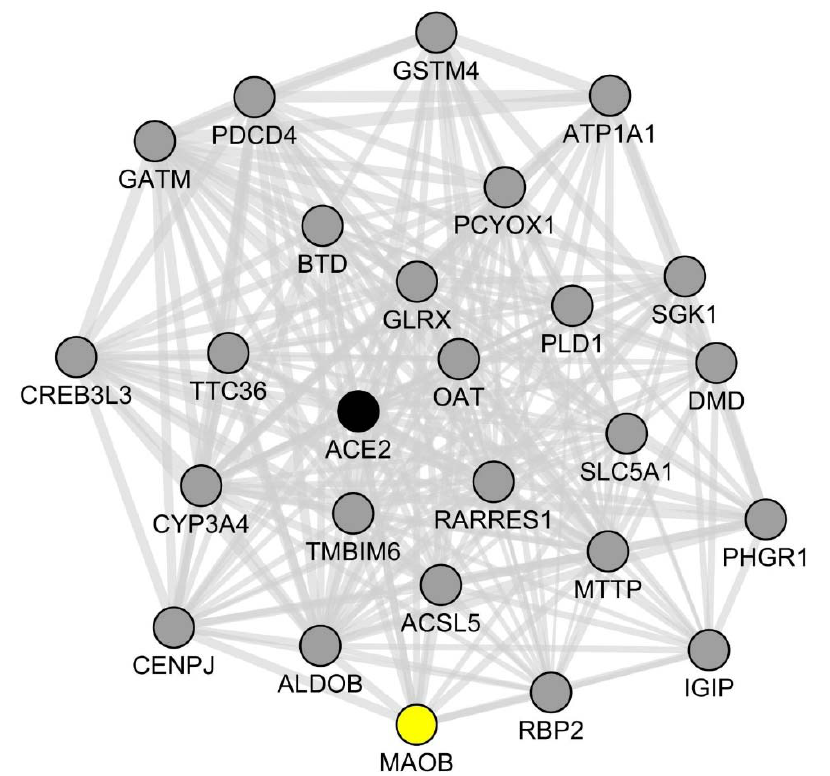
Figure 3. ACE2 co-expression network in SARS-CoV2-infected human intestinal organoids. A set of previously published RNA-seq data [34] obtained from the analysis of SARS-CoV2-infected human intestinal organoids was re-assessed in order to identify the top-25 genes that more closely co-express with ACE2 under these experimental conditions. Each gene is represented by its gene symbol and a plain circle. Each correlation link is represented by a plain gray line. The full list of ACE2 co- expressed genes is shown in Table S1. MAOB (represented as a yellow plain circle), a crucial gene of the dopamine/trace amines metabolic pathways, co-expresses with ACE2 (represented as a black plain circle) and other genes of the identified ACE2 co-expression network.